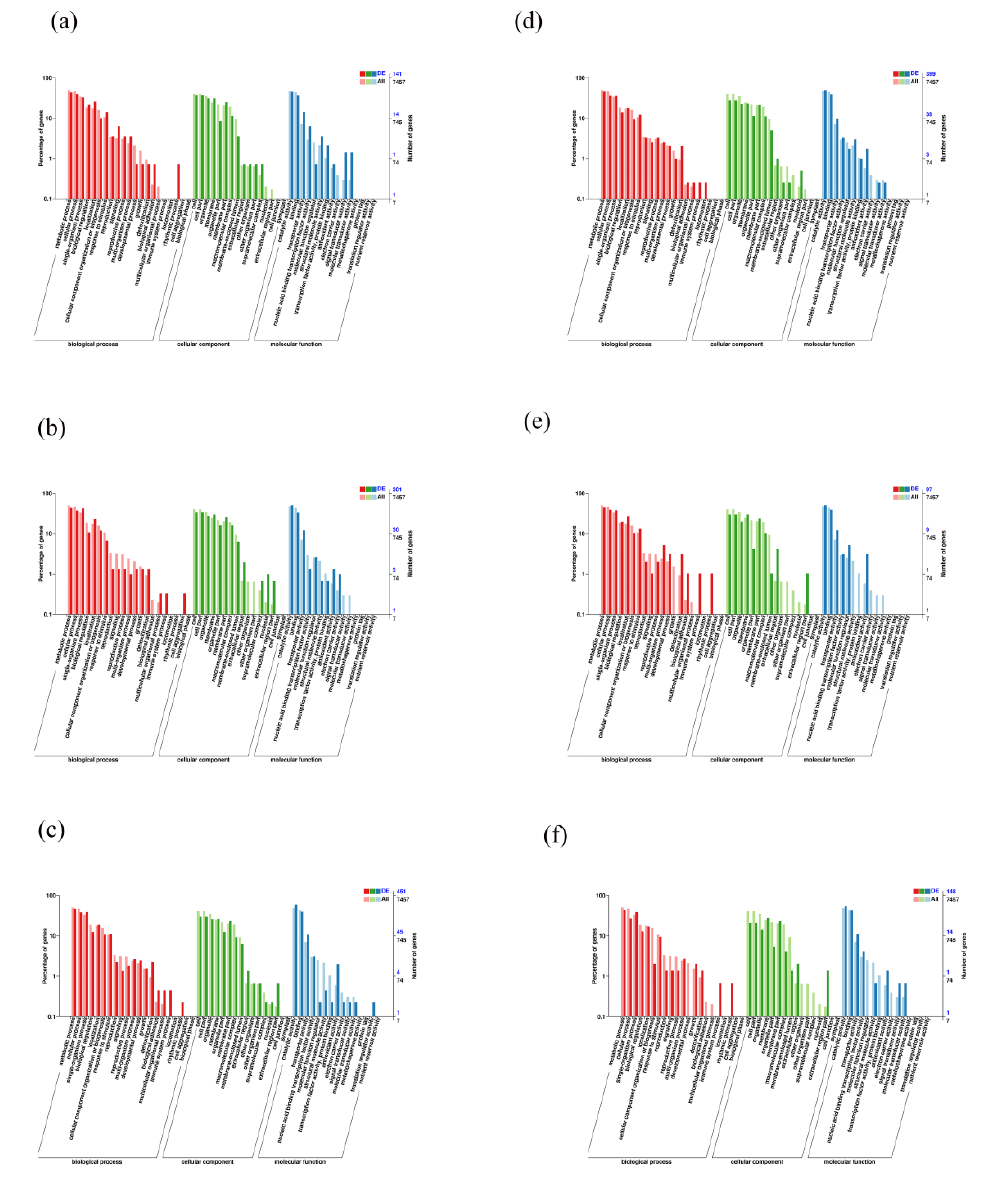
Figure 6. Annotation of GO secondary nodes of differentially expressed genes and all genes in six Cenococcum geophilum isolates under temperature stress. ( a ) ACg07 (25 °C vs. 30 °C), ( b ) ChCg28 (25 °C vs. 30 °C), ( c ) ChCg100 (25 °C vs. 30 °C), ( d ) ChCg01 (25 °C vs. 30 °C), ( e ) JaCg144 (25 °C vs. 30 °C), ( f ) JaCg202 (25 °C vs. 30 °C).